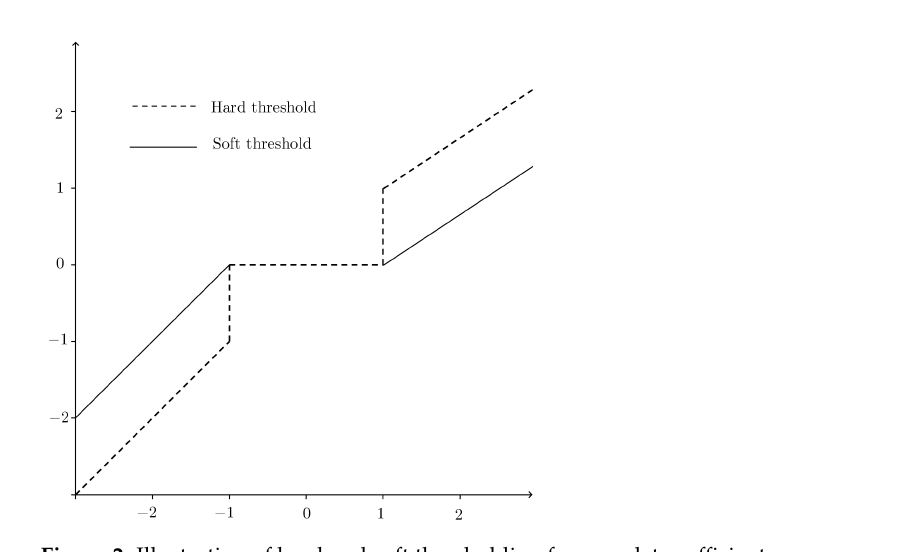
Figure 2. Illustration of hard and soft thresholding for wavelet